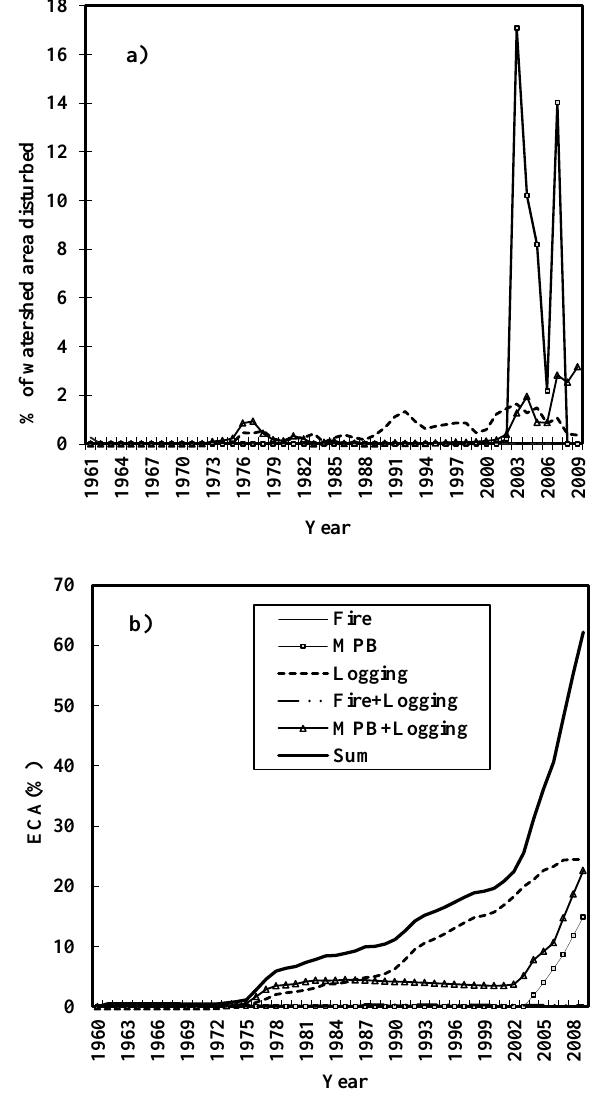
Fig. 5. Cumulative equivalent clear-cut area (ECA) from 1961 to Cumulative equivalent clear-cut area (ECA) from 1961 to 2009 980